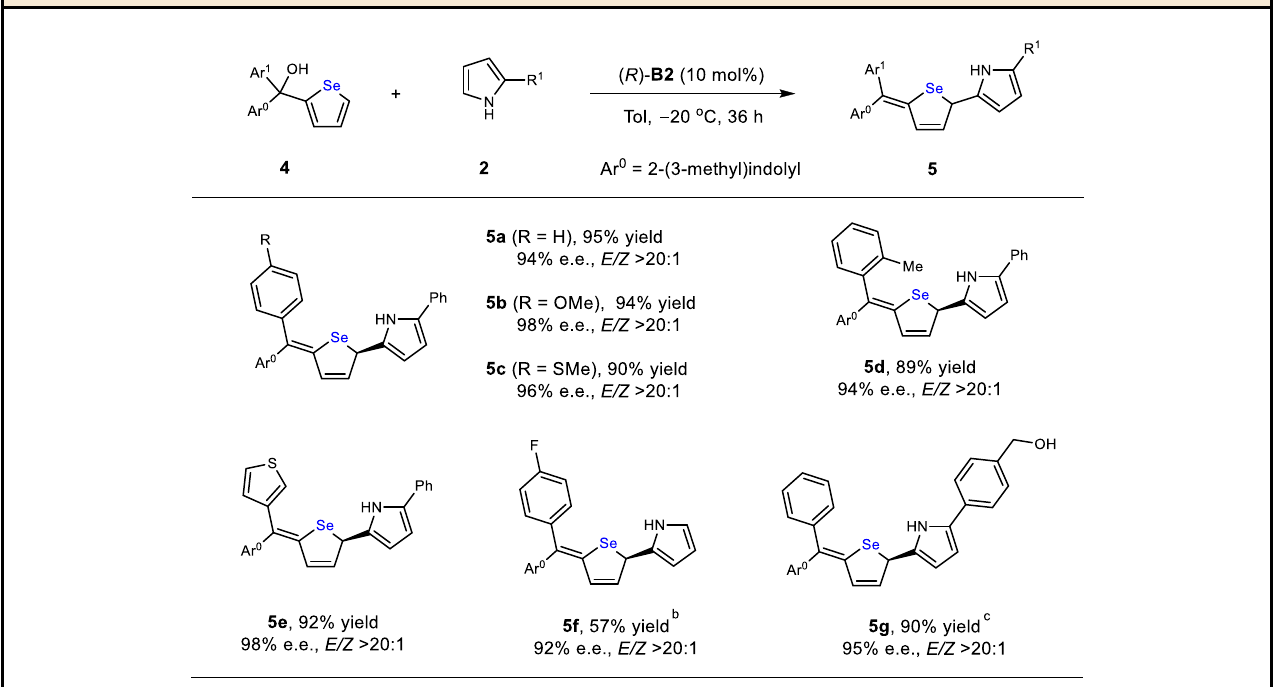
Table 3 Enantioselective dearomatization of selenophenes a